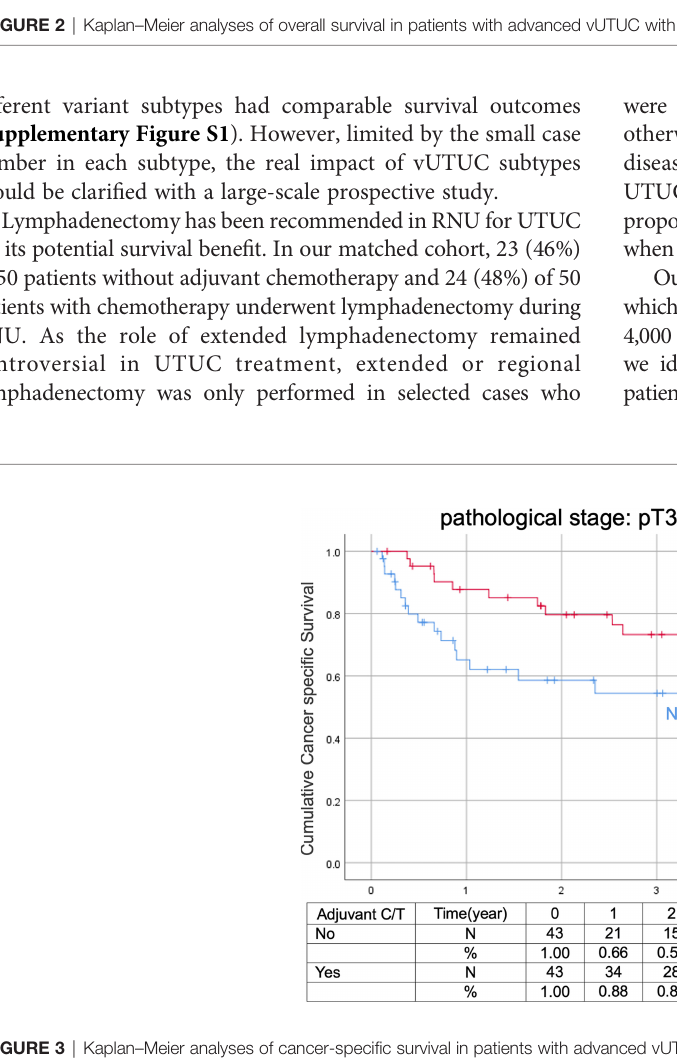
FIGURE 3 | Kaplan – Meier analyses of cancer-speci fi c survival in patients with advanced vUTUC with or without adjuvant chemotherapy.